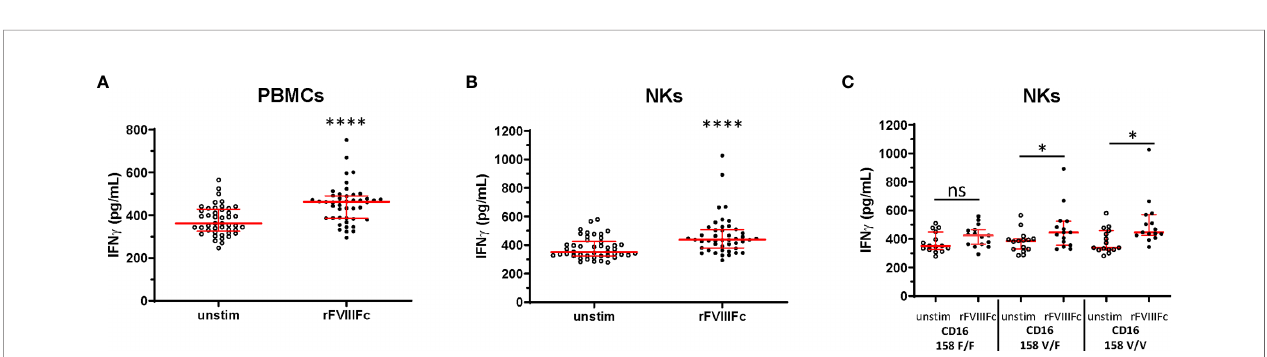
FIGURE 3 | rFVIIIFc induces IFN g secretion from peripheral blood mononuclear cells and NKs isolated from healthy human donors. IFN g secretion from PBMCs (A) or resting NK cells (B) isolated from 15 healthy human donors each measured in triplicate by ELISA following overnight stimulation with rFVIIIFc (250 nM). (C) IFN g secretion from resting NK cells with distinct CD16 V/F 158 genotypes (CD16 158 F/F, V/F, V/V; n = 5, each measured in triplicate). (A – C) Median ± inter-quartile range (IQR) indicated in red. Wilcoxon signed rank tests (two-tailed) were performed for comparisons between unstimulated and rFVIIIFc-stimulated cells. *p < 0.05, ****p < 0.0001. ns, not signi fi cant, p > 0.05.